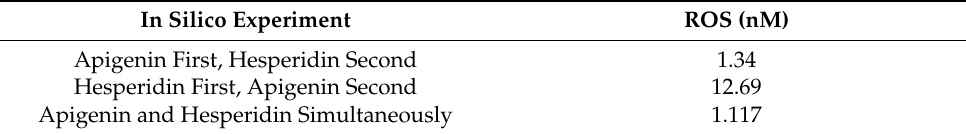
Table 5. Estimations for additive ranges of ROS.